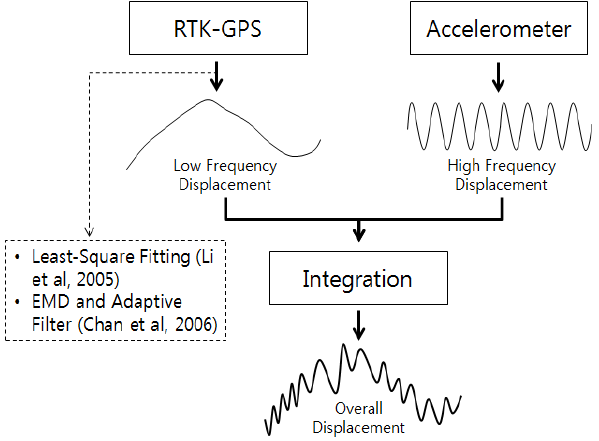
Figure 5. Concept of the integrated calculation according to frequency-based displacement